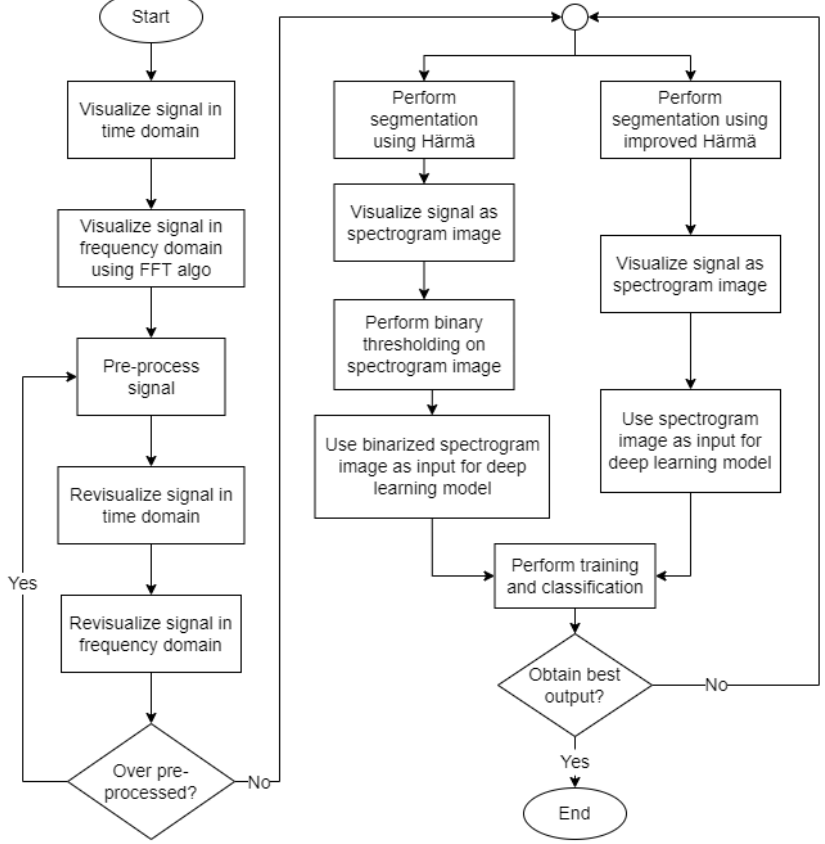
Figure 2. Flowchart of the proposed cicada species recognition system.